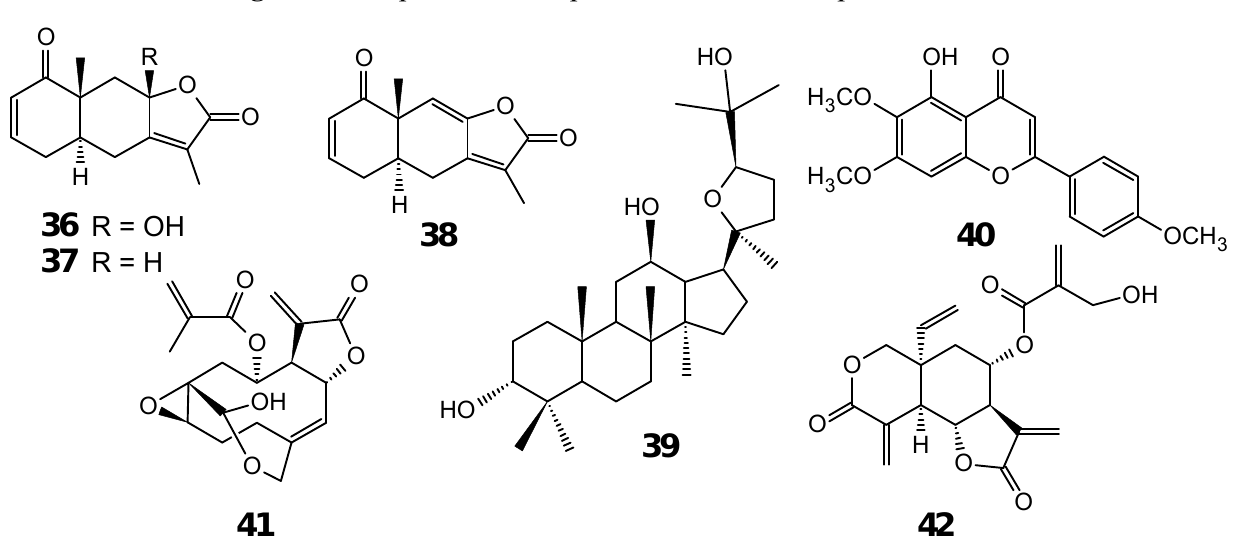
Figure 6. Antiplasmodial terpenes and related compounds 36-42